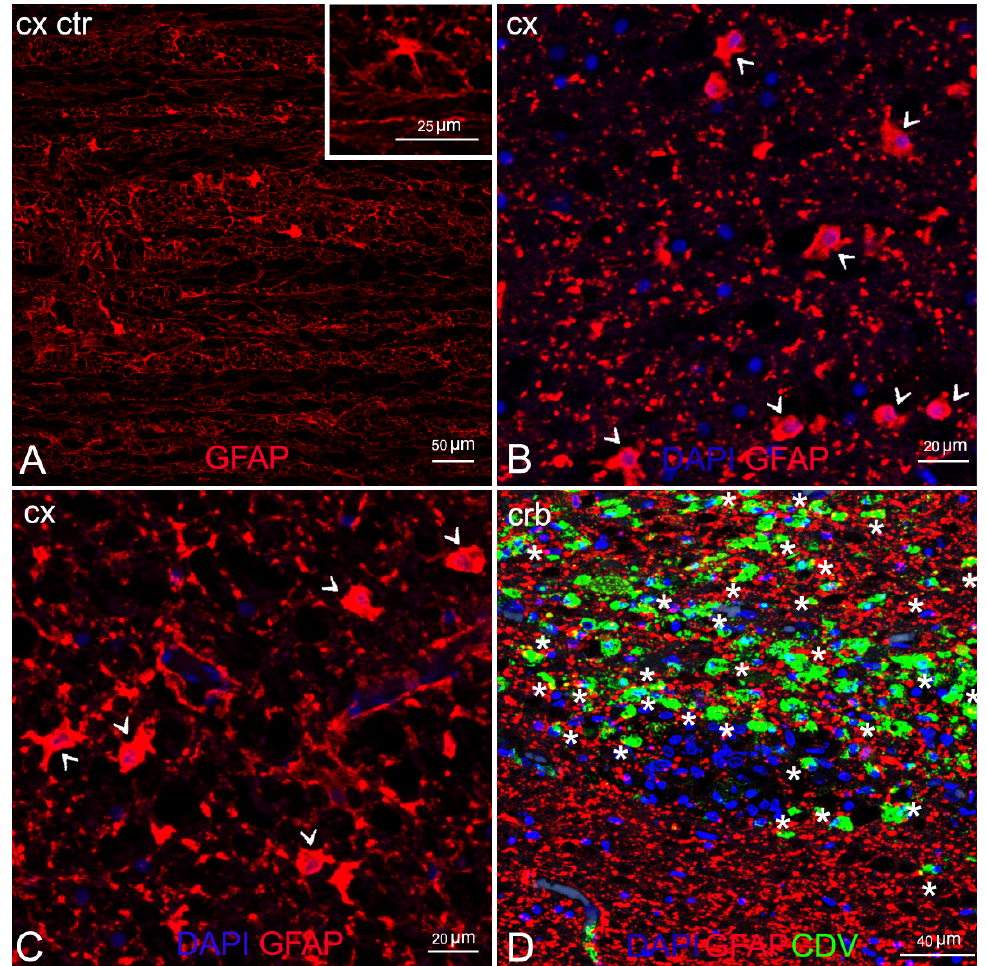
Figure 5. Characterization of demyelinated areas by means of double IF for astrocytes and DMV. ( A ) Cerebral cortex (negative control). Inset: cerebral cortex (negative control). Astrocyte in resting- state. ( B ) Cerebral cortex (ID 9). Several reactive astrocytes (arrowhead). ( C ) Cerebral cortex (ID 28). Several reactive astrocytes (arrowhead). ( D ) Cerebellar cortex (ID 10). Viral infection in astrocytes, co-localization anti-CDV and anti-GFAP visible in yellow (asterisks). Legend: Cx, cortex; Crb, cerebellum; Ctr, negative control; DAPI, 4,6-diamidino-2-phenylindole; DMV, dolphin morbillivirus; CDV, canine distemper virus.